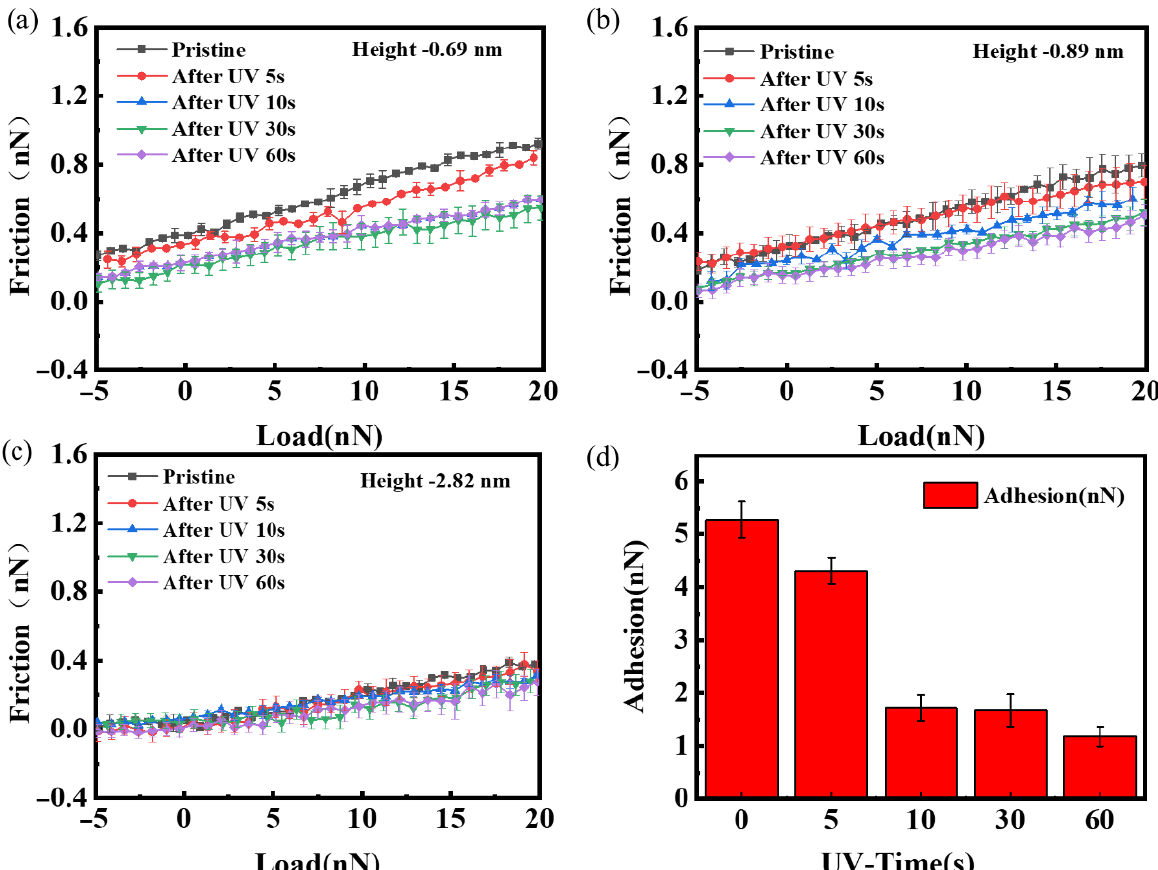
Figure 4. ( a – c ) The relationship between friction force and load of different graphene nanosheets in the UV vacuum irradiation time range of 0 s to 60 s. ( d ) Adhesion of graphene after UV vacuum treatment at different times (10 nN load).